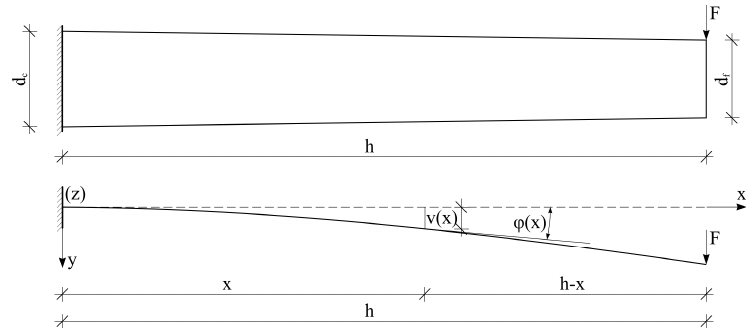
Figure 1. A mathematical model and characteristic deformation of the cantilever beam.